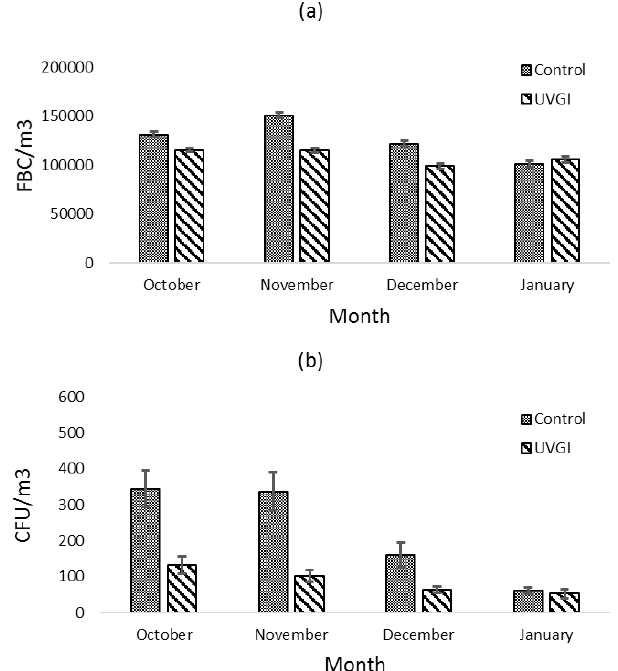
Figure 4. Comparison of results from two bioaerosols sampling methods ( a ) Monthly FBCs RBMs at fine size B (<7 μm) in UVGI and non-UVGI control classrooms before the adjustment. ( b ) The monthly concentration of airborne culturable bacteria using Andersen impactor at the fine size (<8 μm) in the UVGI and non-UVGI control classrooms. CFU: colony forming units.